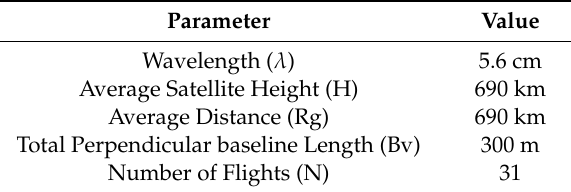
Table 2. Simulation experiment parameter